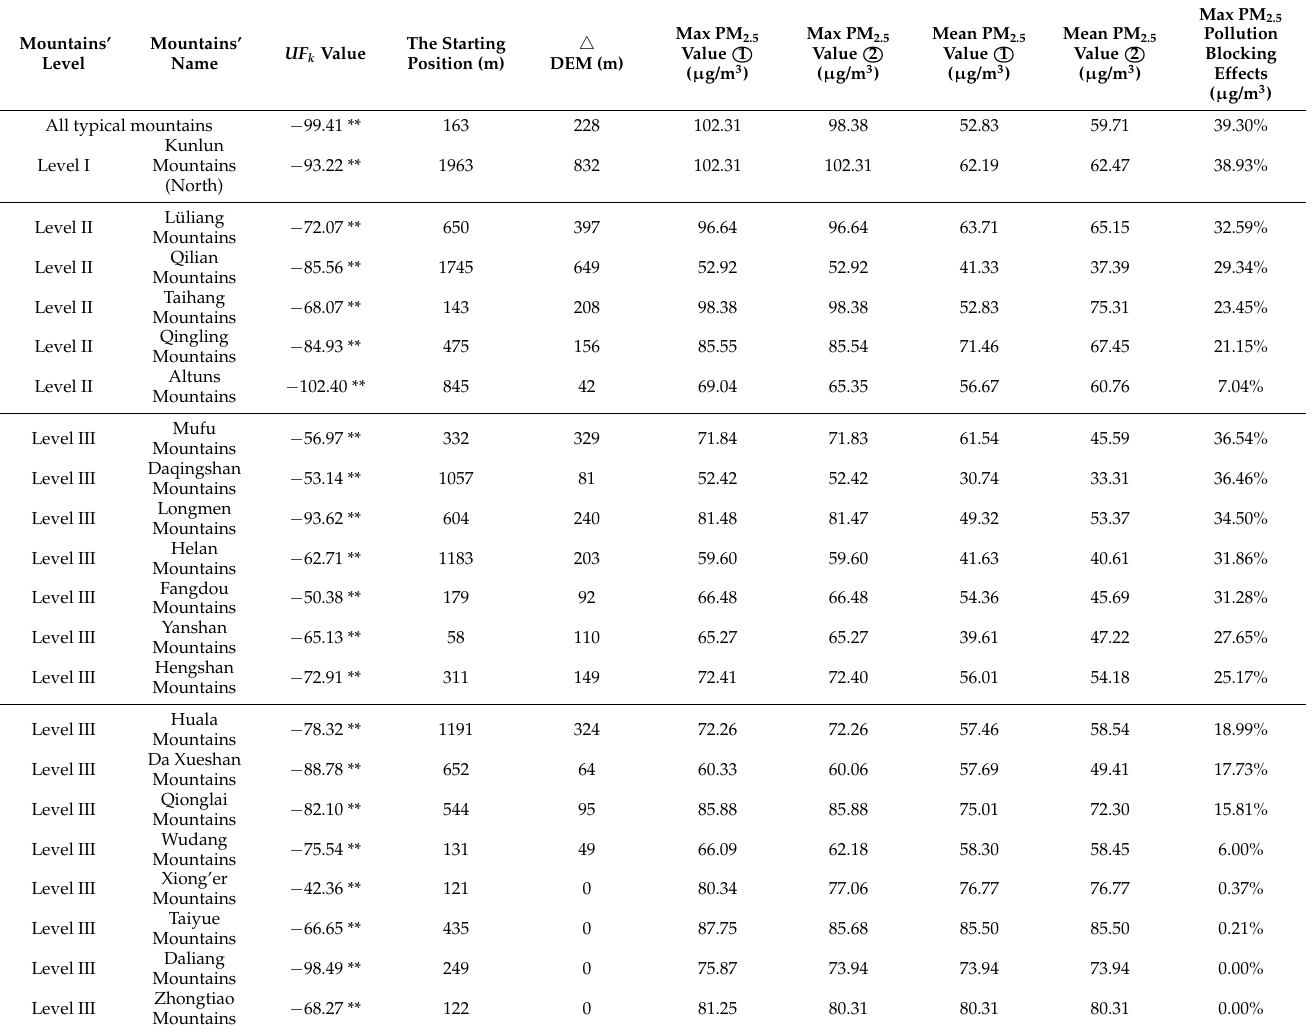
Table 3. The results of M-K test for the typical